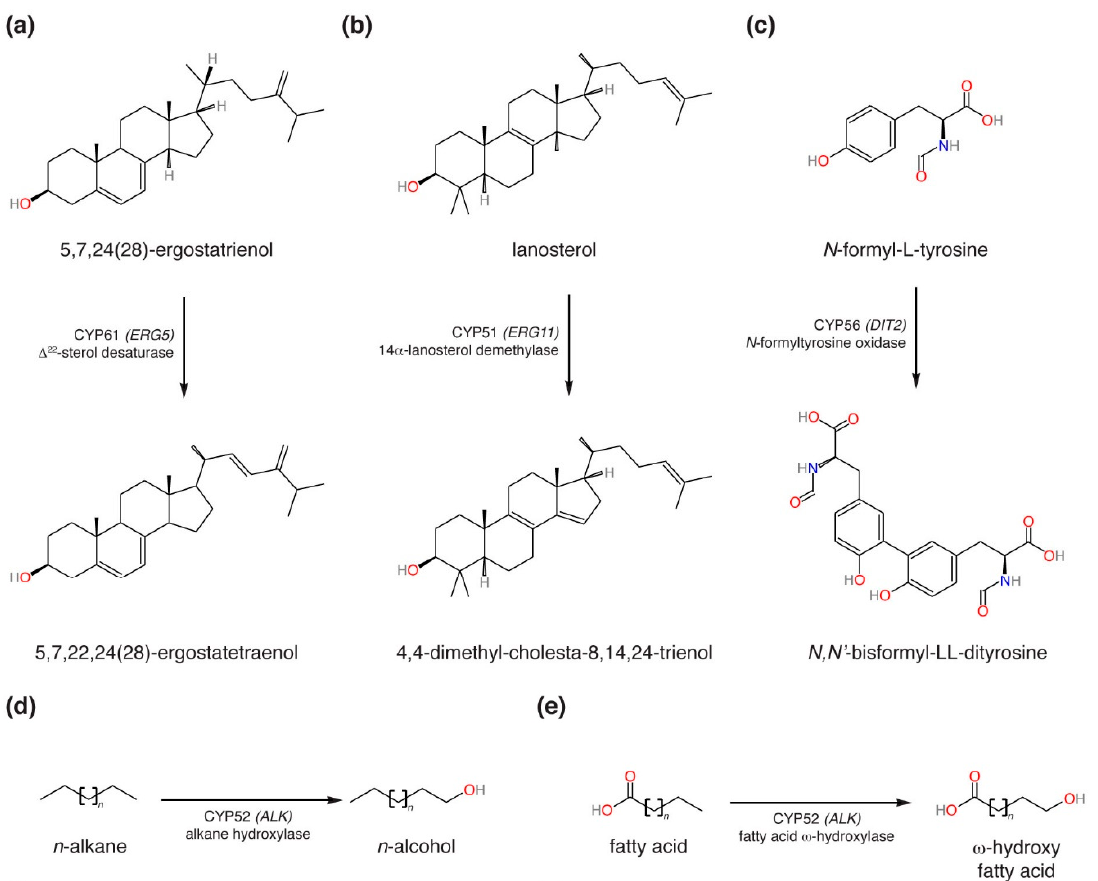
Figure 1. Currently known cytochrome P450 monooxygenase (CYP) enzymatic activities among budding yeasts: ( a ) Δ 22 -sterol desaturase; ( b ) 14 α -lanosterol demethylase; ( c ) N -formyl- L -tyrosine oxidase; ( d ) n -alkane hydroxylase; ( e ) fatty acid ω -hydroxylase; ( f ) fatty acid ( ω -1)-hydroxylase; ( g ) pulcherrimic acid synthase. 2. Materials and Methods 2.1. Sequence Retrieval A core set of budding yeast cytochrome P450 monooxygenase (CYP) protein sequences in GenBank were collected through a PSI-BLAST search using the Sac. cerevisiae Erg5 sequence (GenBank protein accession NP_013728) as a query against the nr and refseq_protein databases constrained to sub-phylum Saccharomycotina (taxid:147537) with the E value inclusion threshold set to 10 − 10 . The search was repeated until no new sequences were identified. Identification of CYP protein sequences in the species Blastobotrys adeninivorans , Lachancea kluyveri , Lachancea waltii , Nakaseomyces bacillisporus , Nakaseomyces bracarensis , Nakaseomyces castellii , Nakaseomyces delphensis , Nakaseomyces nivariensis , and Torulaspora microellipsoides were carried out using the GRYC BLAST server (http://igenolevures.org/). CYP families that appeared to be absent in annotated yeast genomes